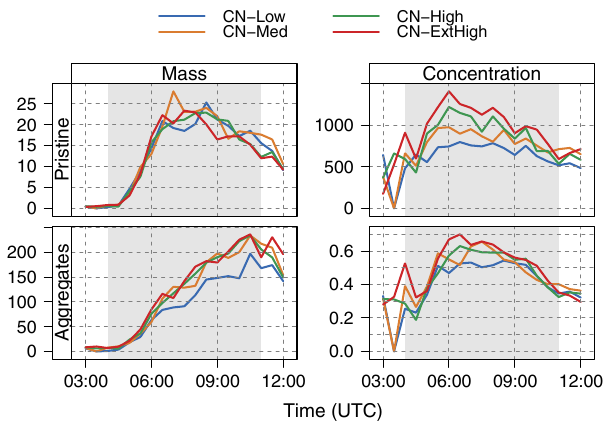
Figure 13. As in Fig. 11, but for pristine ice and aggregate cate- gories.